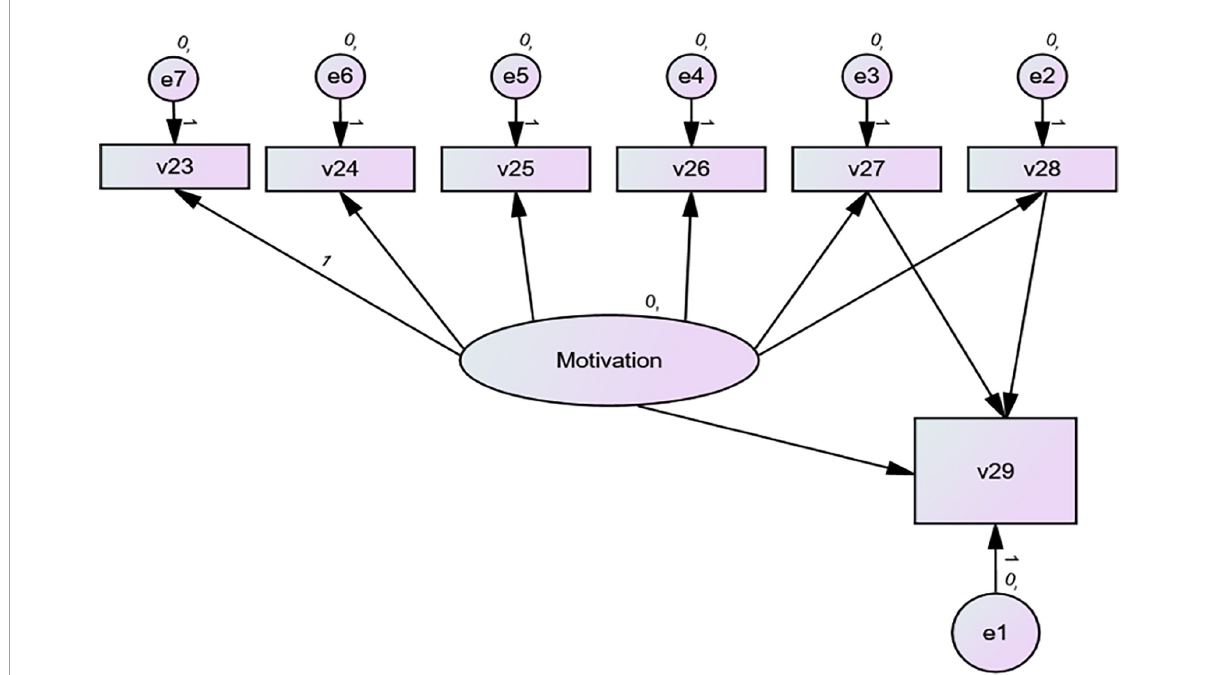
FIGURE1 The default model. V23, attitudes toward English native speakers; V24, intrinsic interest; V25, English culture; V26, ultimate goal; V27, learning situation; V28, parental encouragement; V29, motivational